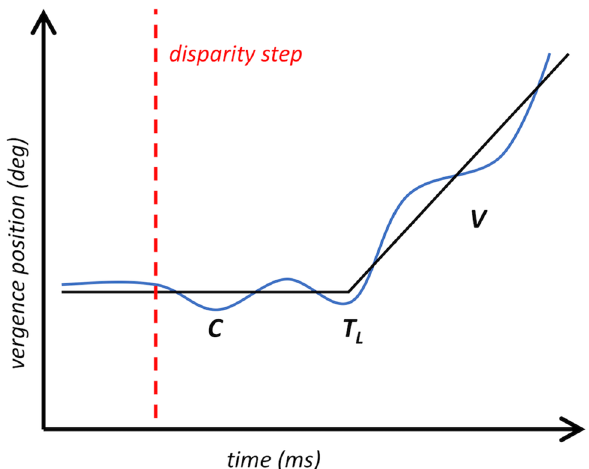
Figure 6. The fitting approach used to estimate the latency and velocity of vergence responses to disparity stimuli. C is a constant reflecting the stable vergence position during the initial latency period, T L specifies one latency interval before the vergence position begins to change, and V is the slope of the line fit to the dynamic vergence